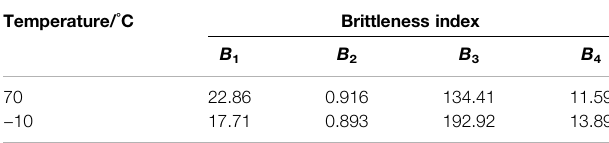
TABLE 3 | Brittleness indices of sandstone at different temperatures.